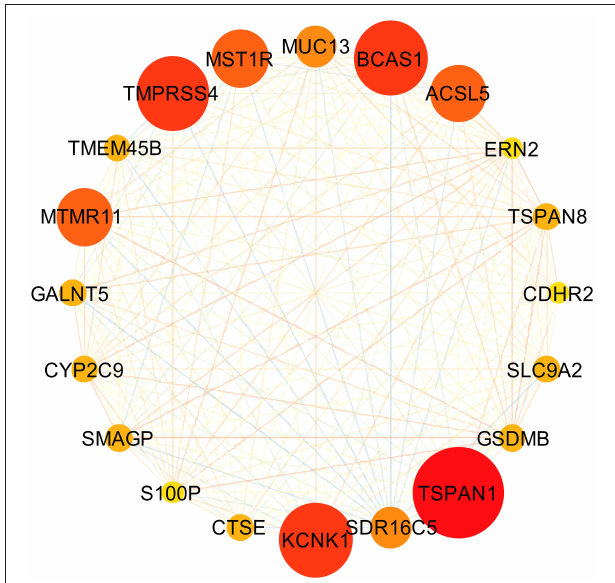
FIGURE 4 | Gene-gene interaction network of the top 20 genes. Through constructing a gene-gene interaction network by using 171 genes obtained from WGCNA analysis, the top 20 genes, ranked by degrees of interactions, were identified.